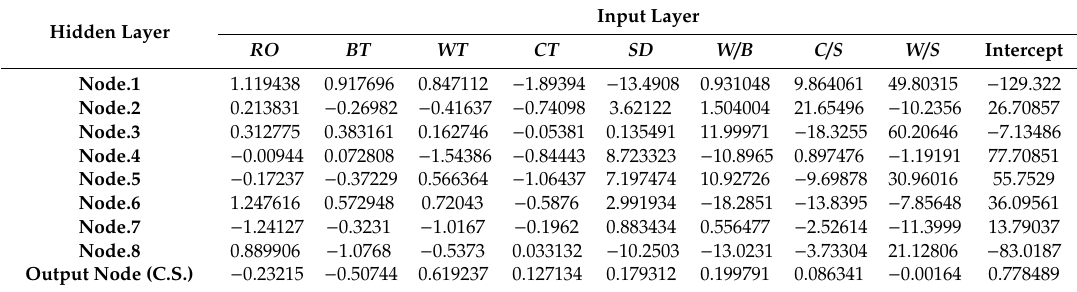
Table 9. Parameter estimates for artificial neural network (ANN) model.